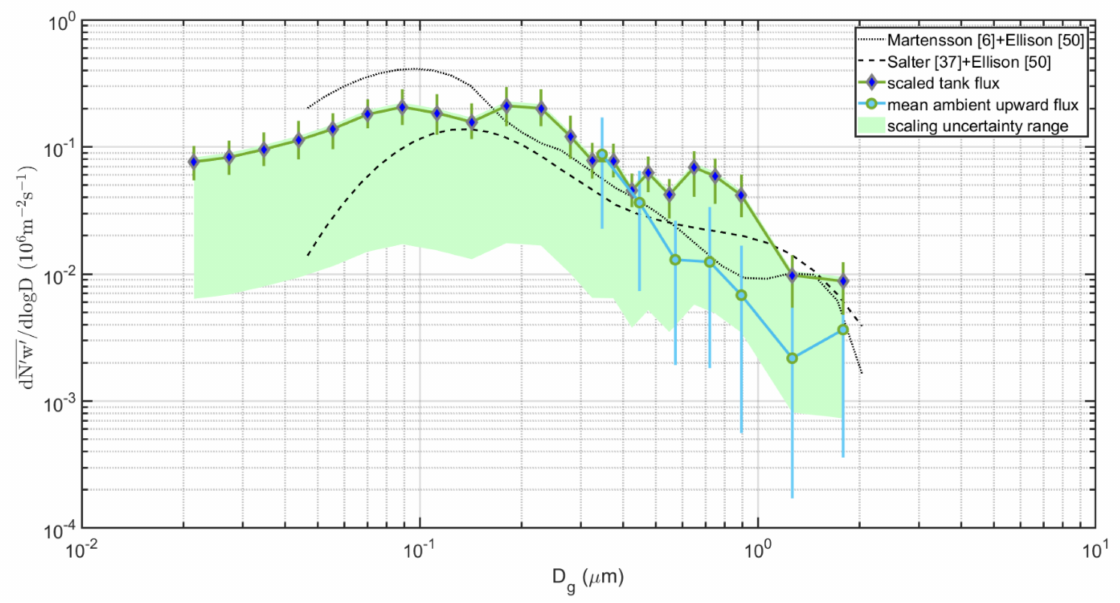
Figure 12. The combined sea spray production spectra from both the bubble tank measurements and in situ EC fluxes. The figure builds on the mean fluxes of periods with both tank data and EC flux data, and with wind speeds larger than 4 ms − 1 (largest wind speed at 15.3 ms − 1 ), with a median of 6.8 ms − 1 and a mean of 7.4 ms − 1 , from the combined Kalmar Strait and long-fetch wind sectors (0 ◦ to 205 ◦ ). Mean ambient upward dry aerosol number fluxes (green circles filled with cyan on a cyan curve with vertical bars for the 10% to 90% percentiles). The bubble tank aerosol concentrations from the differential mobility particle sizer (DMPS) and OPC, attached to the sea spray tank (dark green diamonds filled with dark blue on a dark green curve with vertical bars for the 10% to 90% percentiles), were turned into flux units using the air sample flow and tank water surface, as described in the text. They were furthermore scaled to the smallest OPC bin in the EC aerosol number fluxes. The light green shaded area instead represents the uncertainty range between this scaling and the scaling that resulted from the pair of OPC size bins, which resulted in the largest and most extreme scaling factor between tank and EC system OPCs. The black dashed curve is the combined Salter [37] + Ellison [50] parameterizations, while the dotted black curve is the corresponding Mårtensson [6] + Ellison [50] parameterizations, both with a corresponding mean wind speed of 7.4 ms − 1 . Qualitatively, the long fetch wind sector and coastal wind sector followed a similar pattern to that of the combined ocean sectors used